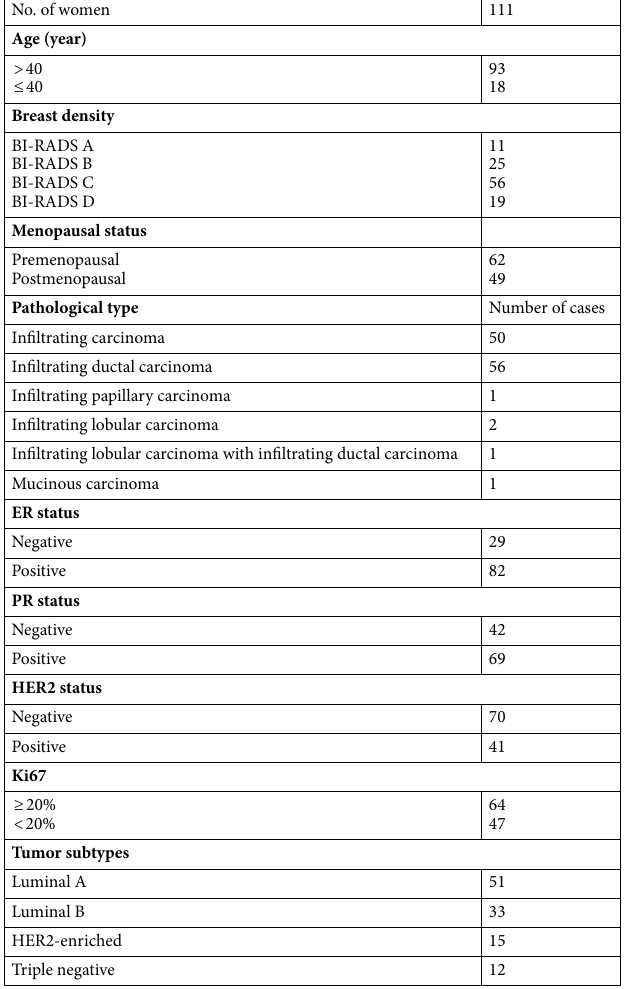
Table 1. Patients demographic characteristics.